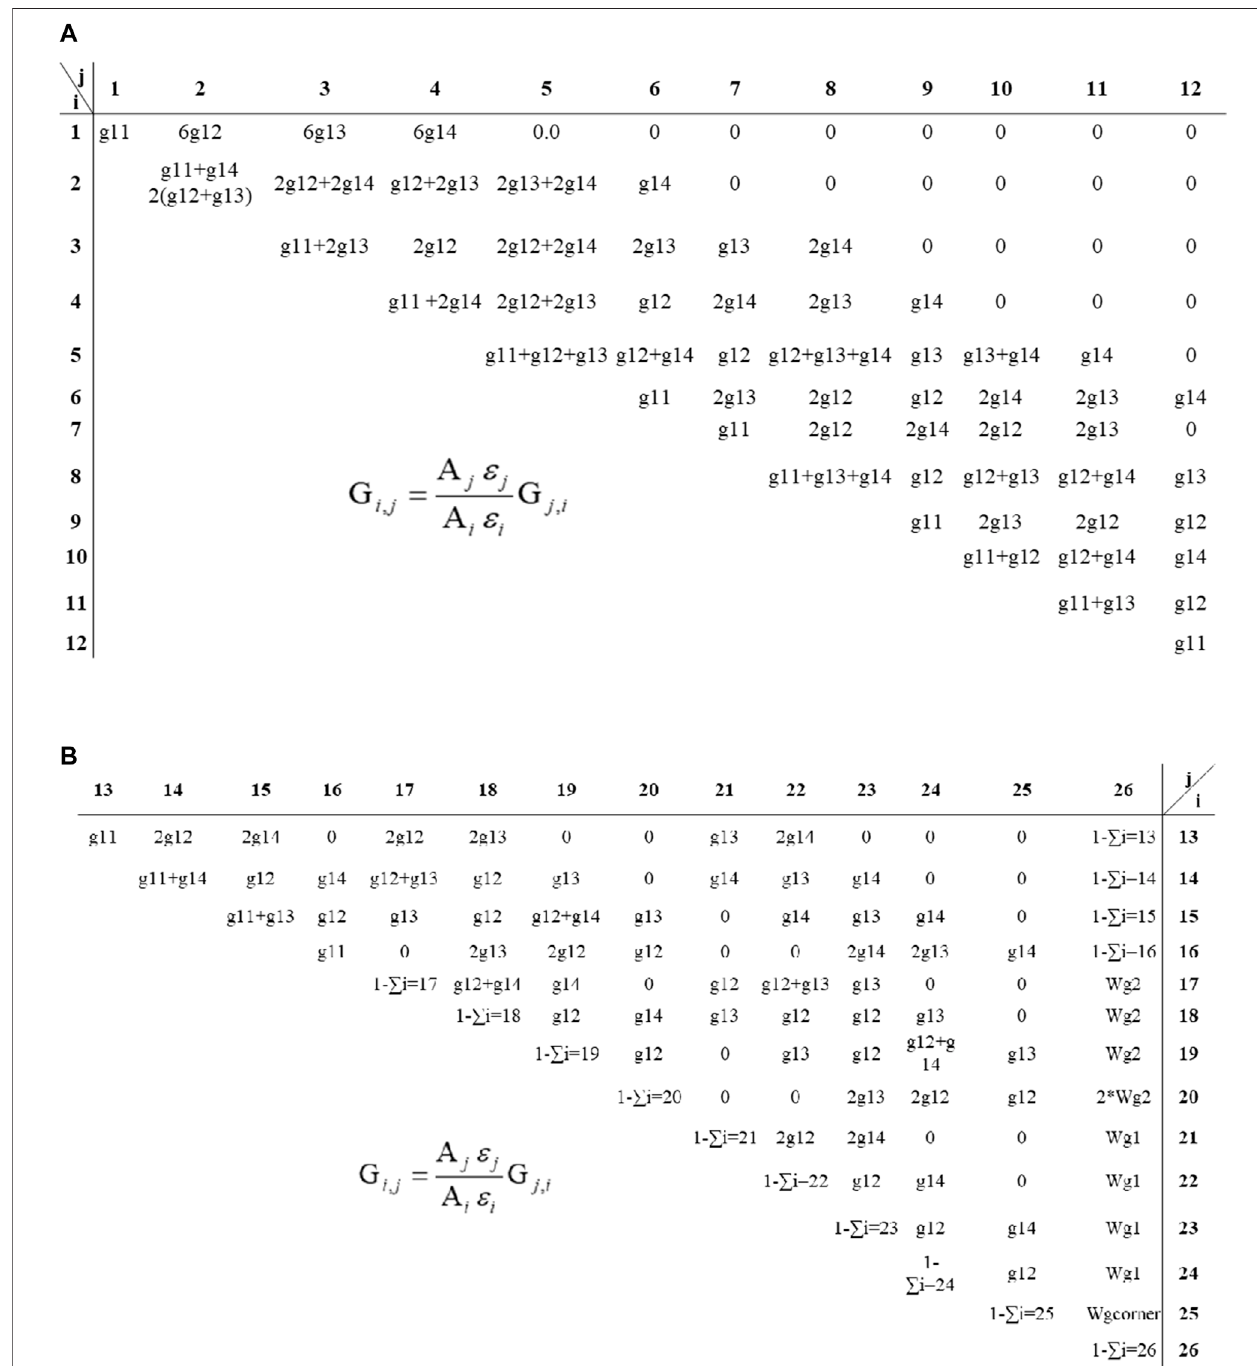
FIGURE 6 | Absorption factor matrix for a hexagonal array: (A) interior and (B) near the wall.